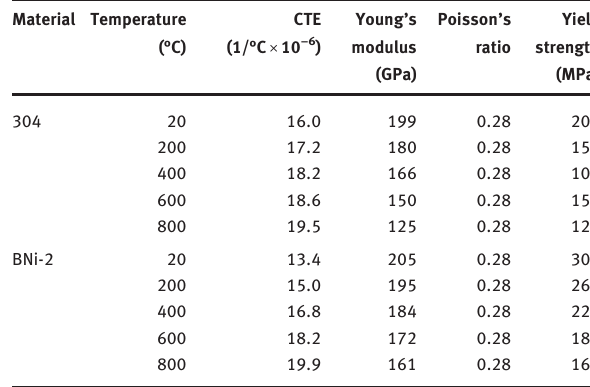
Table 1: Mechanical properties of 304 and BNi-2 [30,